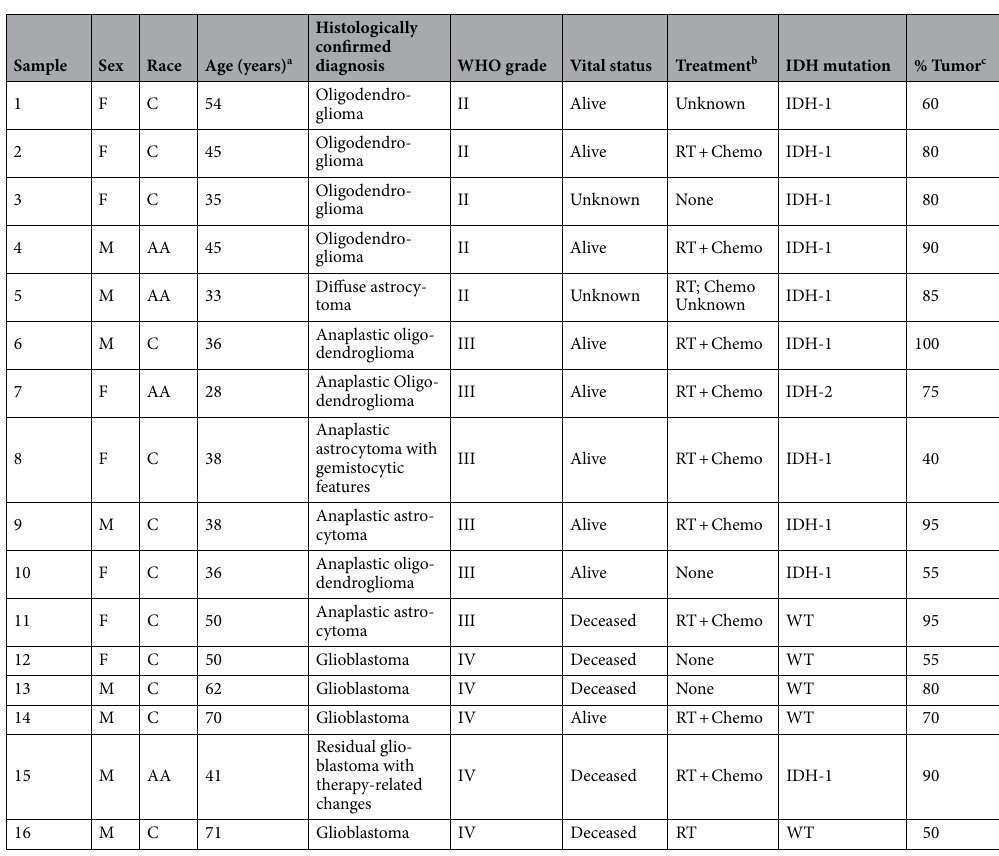
Table 1. Characteristics of the glioma tissue samples. M male, F female, C caucasian, AA African American, WHO World Health Organization, RT radiation therapy, Chemo chemotherapy, IDH isocitrate dehydrogenase, WT wild type. a Age at the time of diagnosis and sample collection. b All patients underwent excision or resection prior to adjuvant treatment. c Percentage of tissue sample that contained tumor, determined histologically.